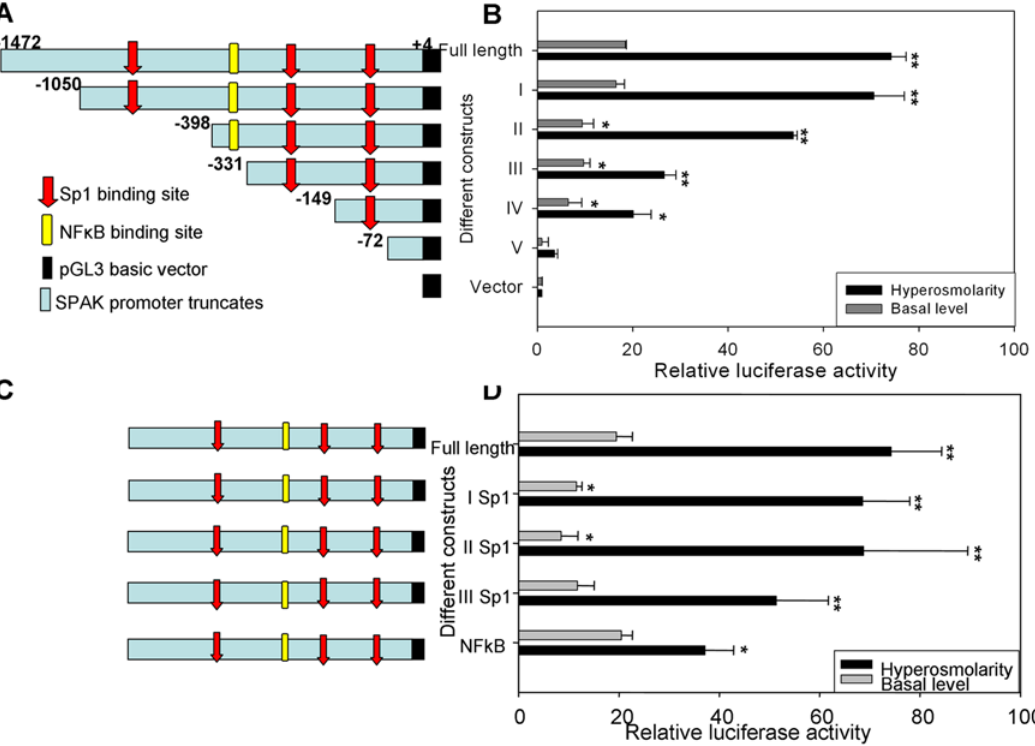
Figure 5. Characterization of SPAK promoter. A. Schematic representation of human SPAK promoter constructs. the full-length SPAK promoter (nt-1472 to + 4); construct I (nt 2 1050 to + 4); construct II (nt 2 398 to + 4); construct III (nt 2 331 to + 4); construct IV (nt 2 149 to + 4) and construct V (nt 2 72 to + 4). Numbers are given in relation to the translational start codon ( + 1) and indicate 5 9 -ends of the deletion constructs. The location of the identified positive regulatory region is indicated by a light blue box. Positions of the putative Sp1 (Red) and NF- k B (Yellow) sites are indicated by arrows. B. Promoter activities of the 5 9 deleted constructs in un-treated or hyperosmolarity-stimulated Caco2-BBE cells normalized to Renilla Luc activities driven by the phRL-CMV control vector. Activities are expressed as fold inductions over cells transfected with the empty pGL3-basic vector. Each value represents the mean 6 SD of at least 3 independent sets of transfection experiments performed in triplicate, *p , 0.05; **p , 0.01. C. Schematic representation of mutated SPAK promoter constructs: the full-length SPAK promoter; I Sp1 binding site ( 2 496); II Sp1 binding site ( 2 303); III Sp1 binding site ( 2 114) and NF- k B binding site ( 2 354). The digits are given in relation to the translational start codon ( + 1). The location of the identified positive regulatory region is indicated by a light blue box. Positions of the putative Sp1 sites are indicated by arrows and NF- k B is indicated by rectangle. The corresponding mutated transcription factor binding site is indicated by black arrow or black rectangle. D. Effects of mutations of Sp1 or NF- k B binding sites on SPAK promoter activity. The various mutated constructs were transiently transfected into Caco2-BBE cells under the basal (gray bar) or hyperosmolarity conditions. Promoter activity of the full-length wild-type construct was set to 100% (control). Values represent means 6 SD of at least 3 independent sets of transfection experiments performed in triplicate, *p , 0.05, **p ,